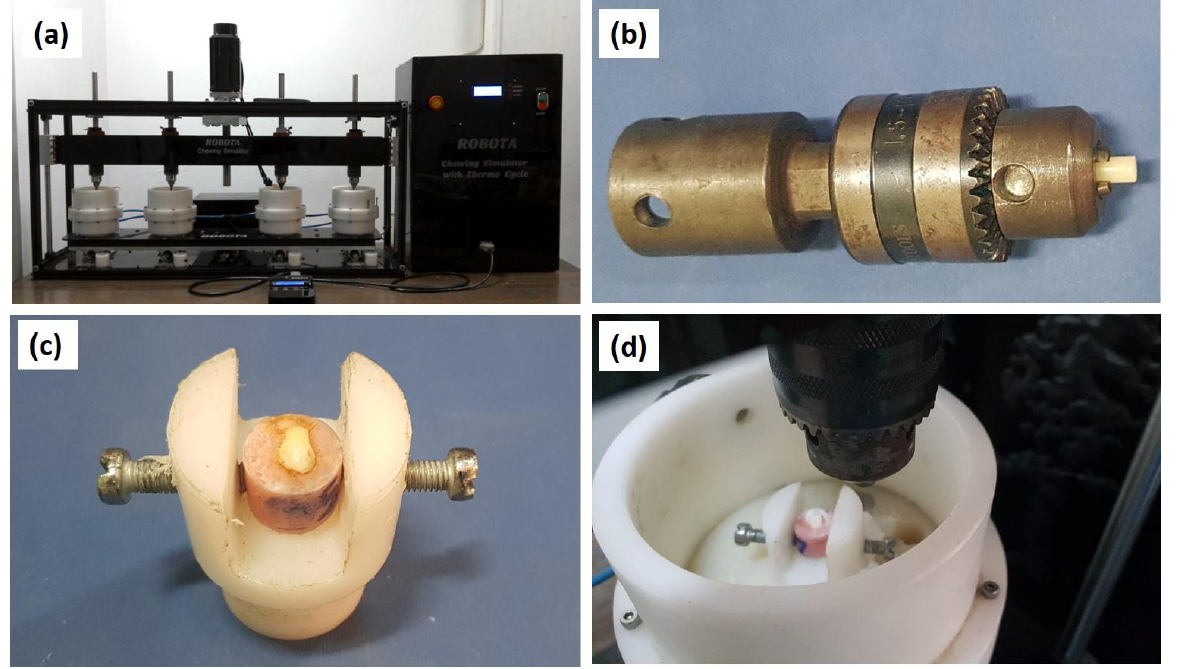
Figure 4. Images of the wear testing stages: ( a ) chewing simulator setup, ( b ) fixing the acrylic teeth sample in the holder, ( c ) plastic holder of the device acting as the antagonist, ( d ) positioning of the upper samples holder in point contact with the teeth surfaces.